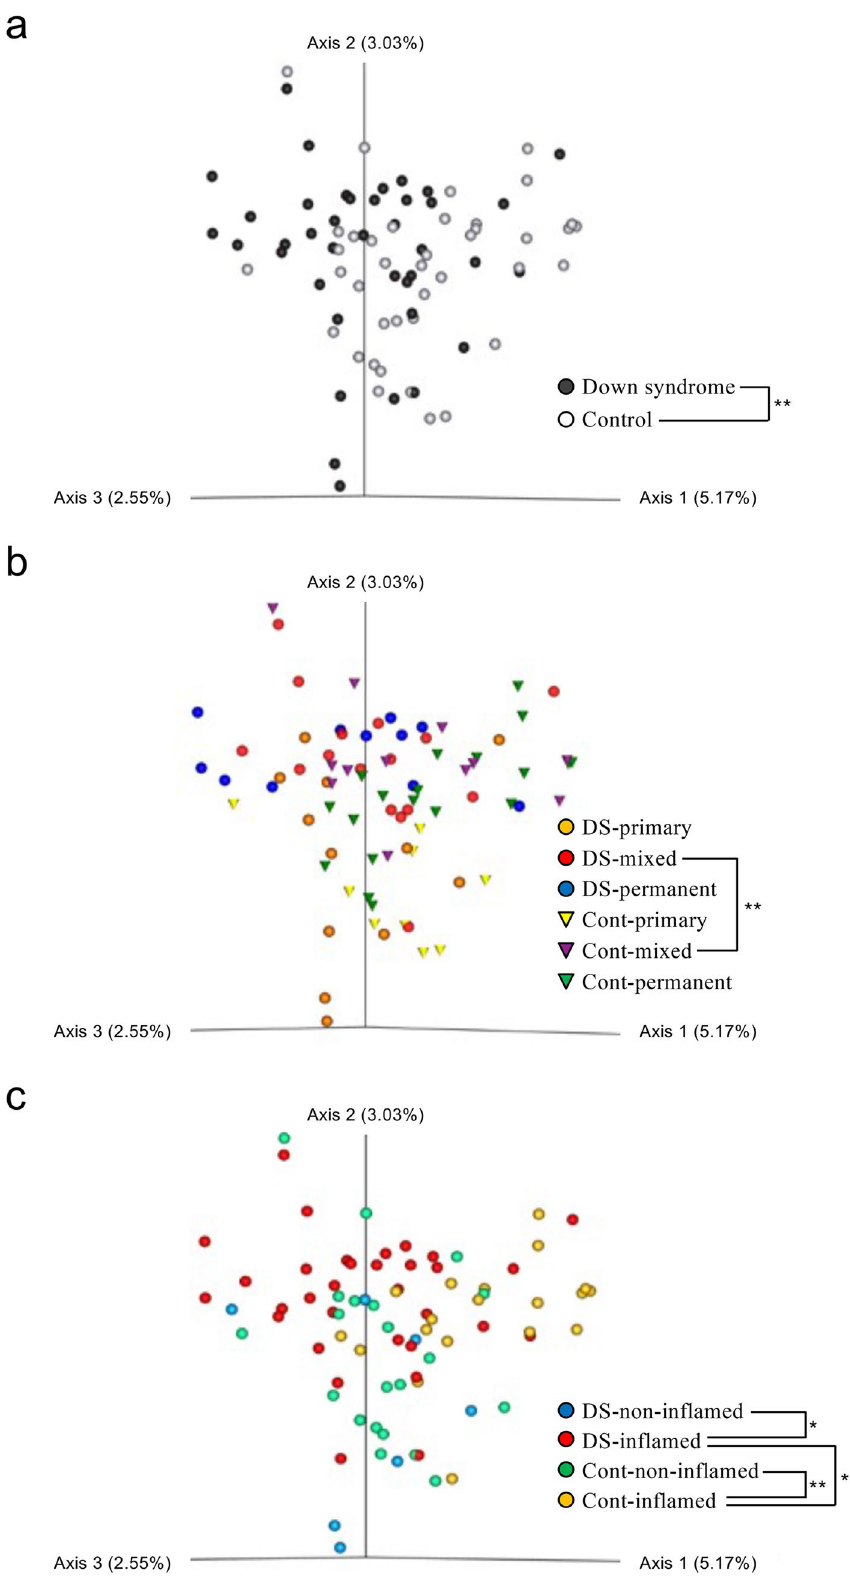
Figure 3. PERMANOVA analysis of β-diversity in the Down syndrome (DS) and control (Cont) groups. Comparisons between the two groups were made for ( a ) all participants, ( b ) dentition stage (mixed, permanent and primary), and ( c ) gingival inflammation status. The contribution rate of each Axis (1–3) in the principal coordinate analysis is shown in parentheses. In this analysis, Axis 1 (3.03%) + Axis 2 (5.17%) + Axis 3 (2.55%) = 10.75%, which is considered to reflect approximately 10% of all of the information. * P < 0.05 and ** P < 0.01 by PERMANOVA analysis of the unweighted UniFrac